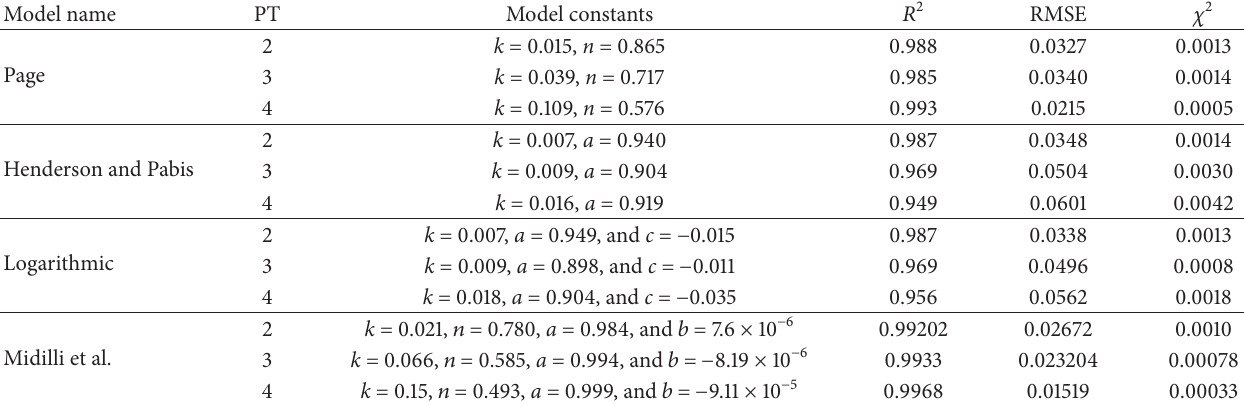
Table 6: Parameters and statistical results for the various drying models for microwave pretreated samples at 600 W.